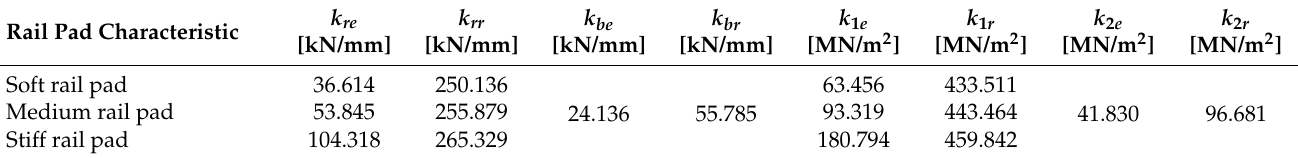
Figure 7. Bilinear approximation of the load-deformation characteristic: color code as in Figure 5; dotted lines – nonlinear function; continuous lines – bilinear approximation. Table 1. Parameters of the bilinear